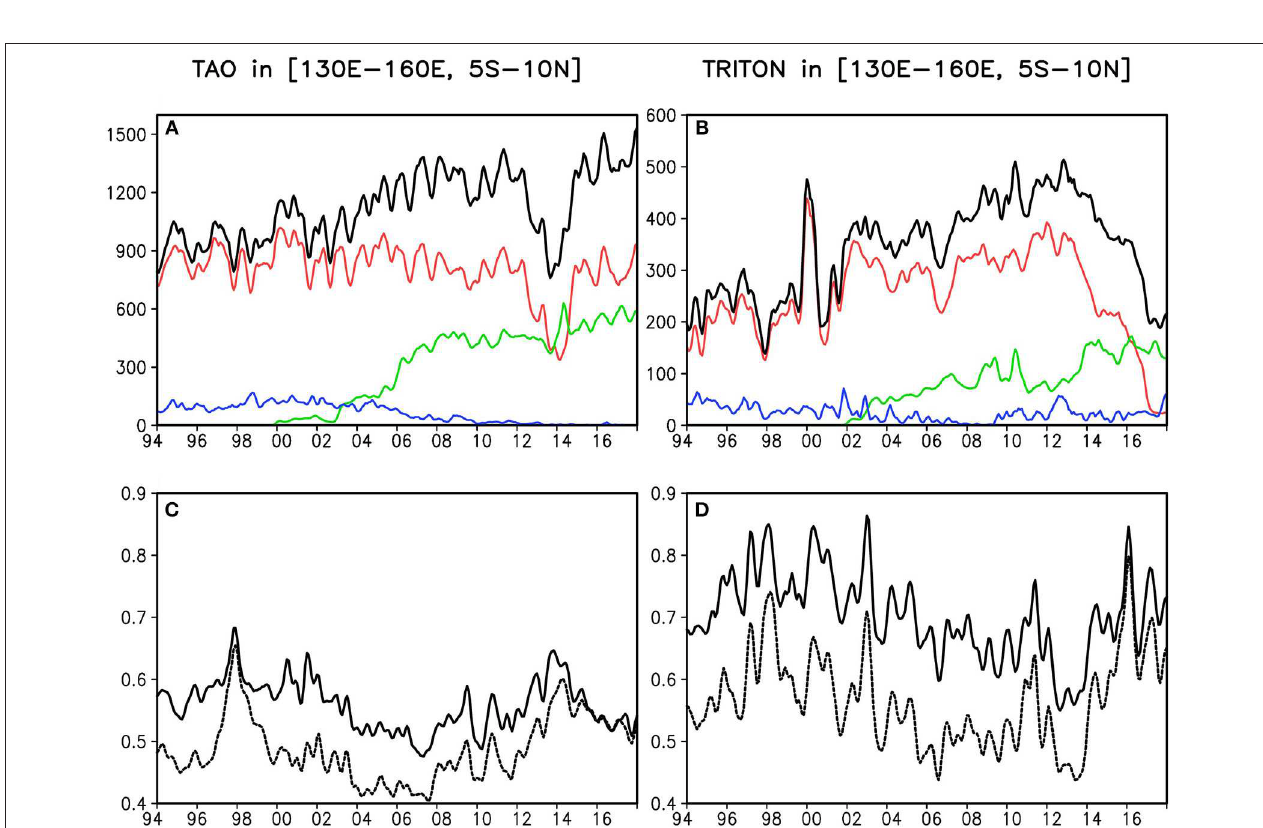
FIGURE 11 | Time variations of the number of daily temperature profiles per month accumulated in the (A) TAO and (C) TRITON array region from the moorings (red line), Argo (green line), XBT (blue line), and all together (black line) from January 1994 to 2018. Time evolution of the multi-system ensemble spread of total temperature (solid lines) and anomalous temperature (dash lines) calculated in the upper 300m for the (B) TAO and (D) TRITON array region from January 1994 to 2018, evaluated in the Real-Time Ocean Ranalysis Intercomparison Project.